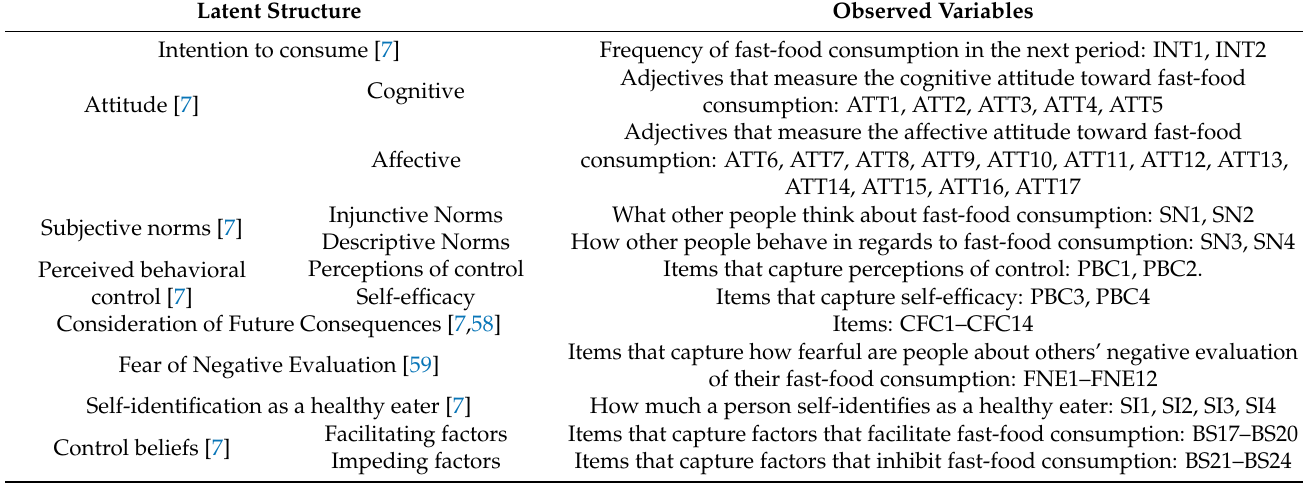
Table 1. Measurement items by latent constructs as provided by extant